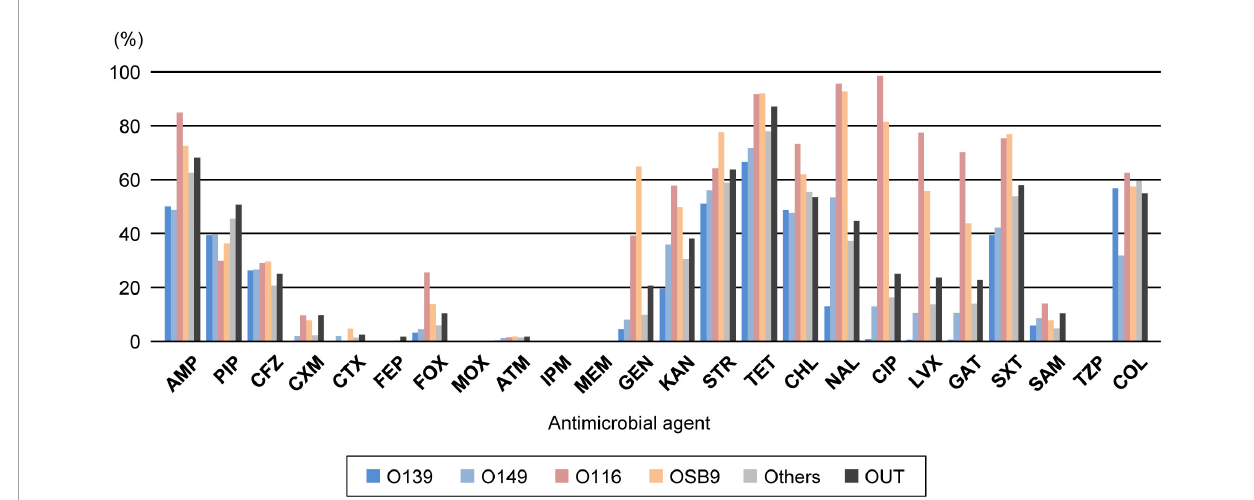
FIGURE2 Comparison of the prevalence of O serogroups and rates of resistance to each antimicrobial. AMP, ampicillin; PIP, piperacillin; CFZ, cefazolin; CXM, cefuroxime; CTX, cefotaxime; FEP, cefepime; FOX, cefoxitin; MOX, moxalactam; ATM, aztreonam; IPM, imipenem; MEM, meropenem; GEN, gentamicin; KAN, kanamycin; STR, streptomycin; TET, tetracycline; CHL, chloramphenicol; NAL, nalidixic acid; CIP, ciprofloxacin; LVX, levofloxacin; GAT, gatifloxacin; SXT, trimethoprim-sulfamethoxazole; SAM, ampicillin-sulbactam; TZP, piperacillin-tazobactam; COL, colistin. O serogroups are indicated with the same colors as those in Figure 1